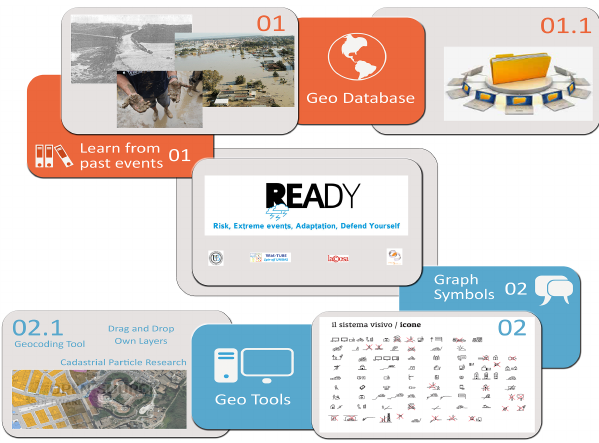
Figure 3. Map of the chosen study area (Basilicata region).